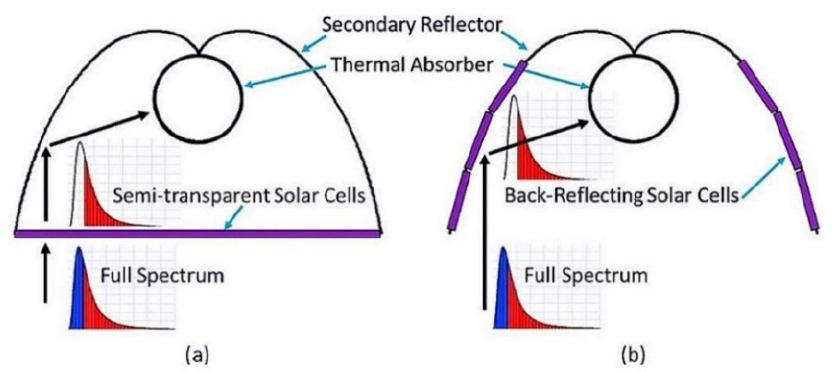
Figure 4. Spectral beam splitting by solar cells (purple) in semi-transparent ( a ) and back-reflecting ( b ) configurations as part of a secondary concentrator. High energy photons are absorbed and low energy photons are either ( a ) transmitted into the secondary concentrator or ( b ) reflected towards the thermal absorber [48].